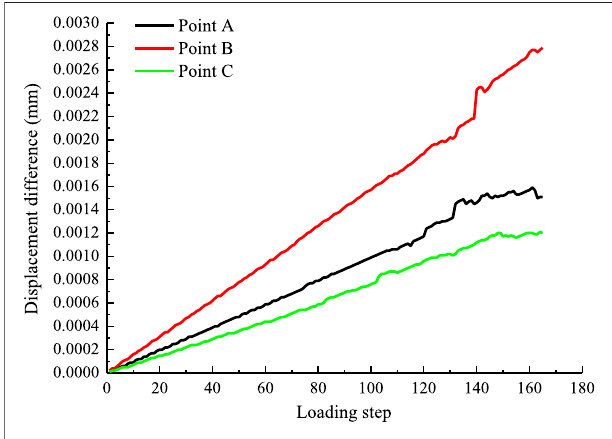
FIGURE 6 | Displacement difference curve of points A, B, and C of two kinds of anchored rock.